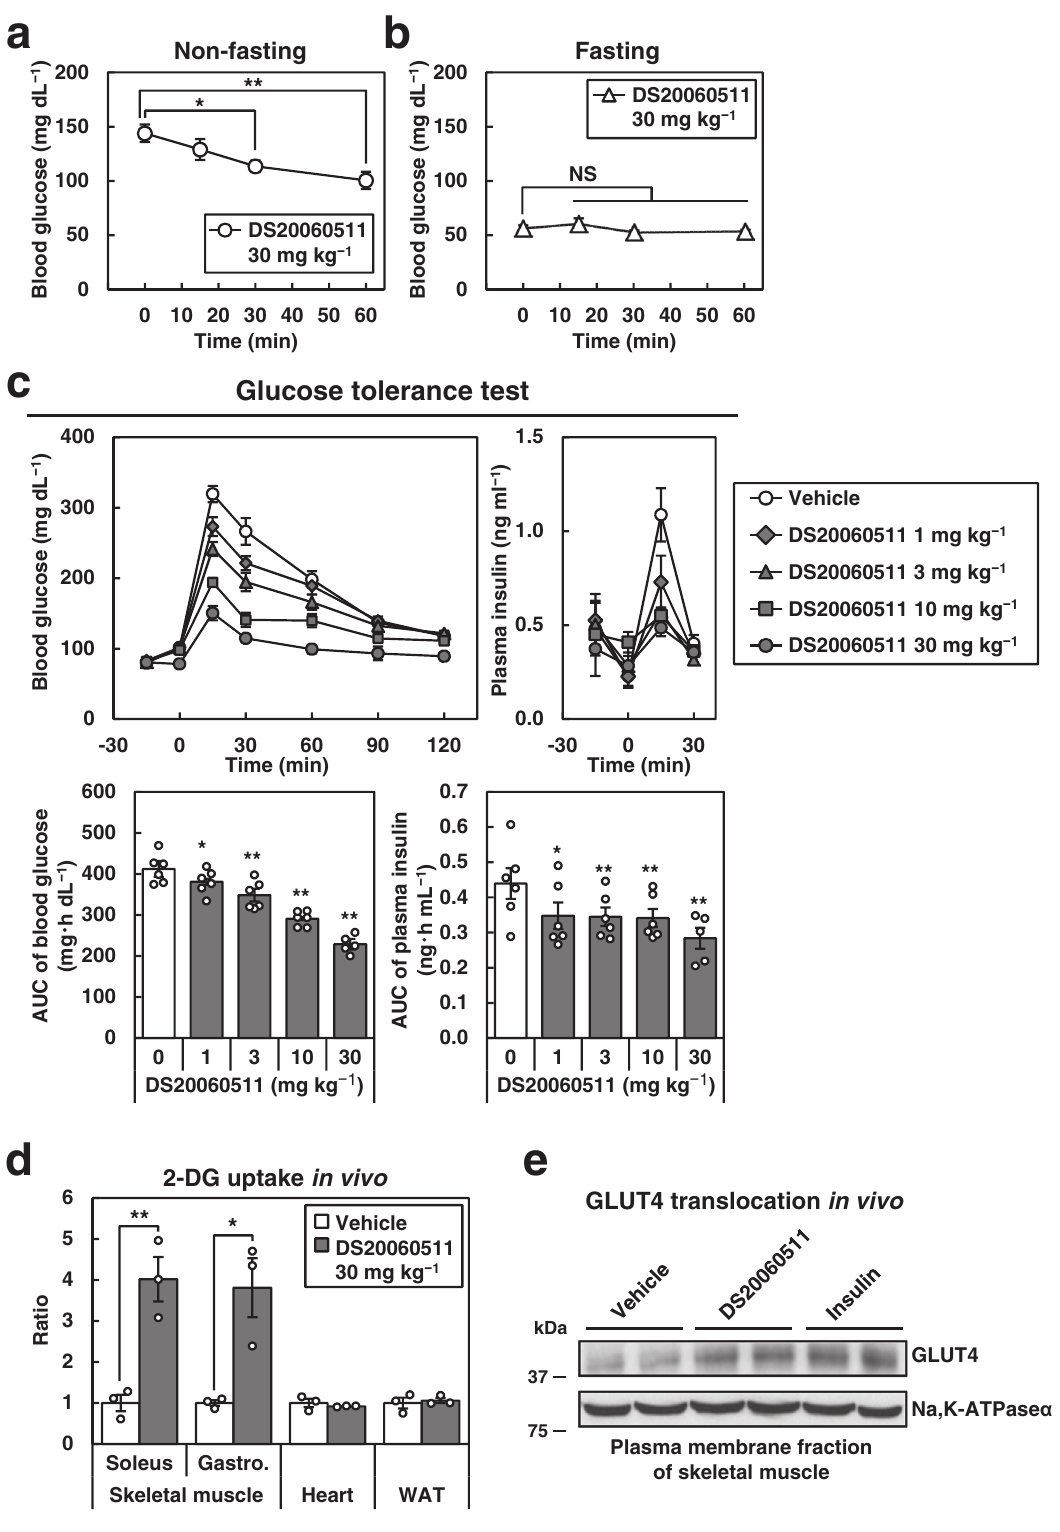
(Fig. 4e). Consistent with these data, 2-DG uptake induced by insulin was also additively increased by concomitant treatment with DS20060511 in isolated skeletal muscles (Fig. 4f). In fact, blood glucose levels were reduced to a greater degree